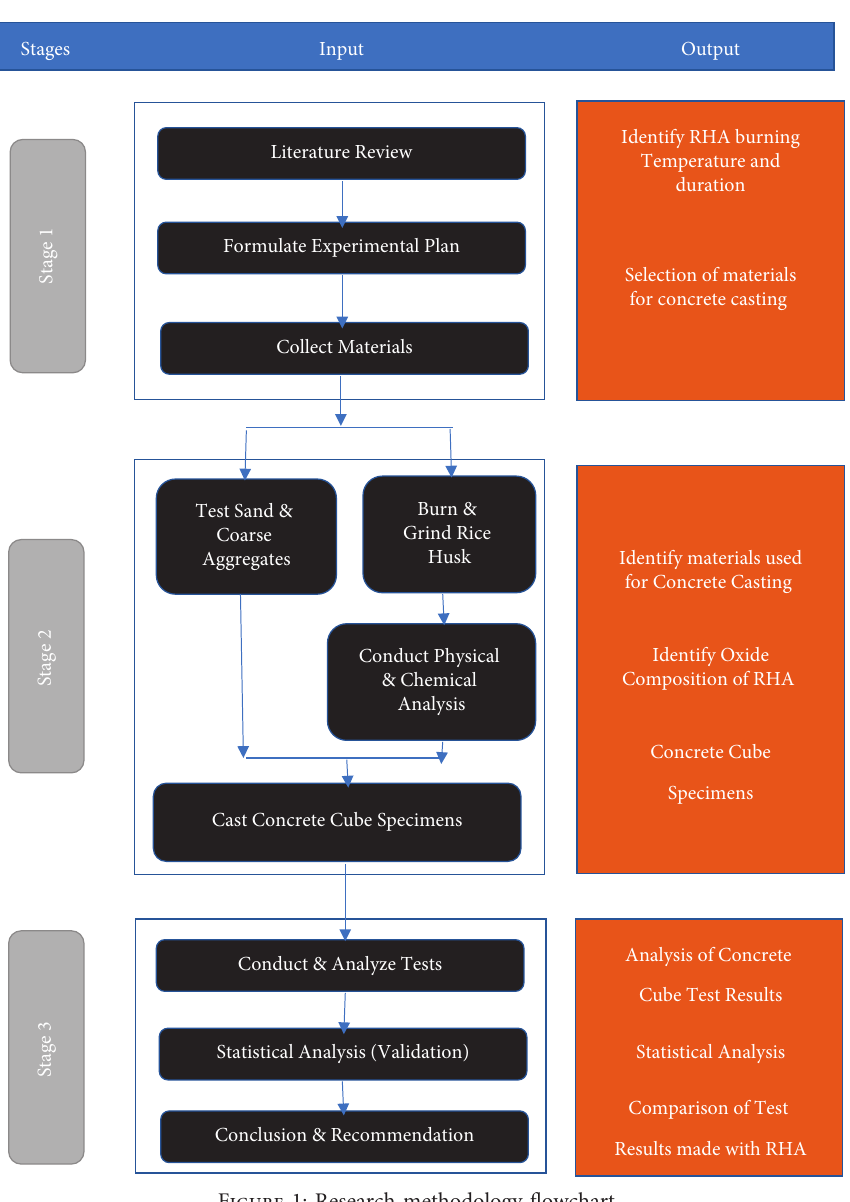
Figure 1: Research methodology